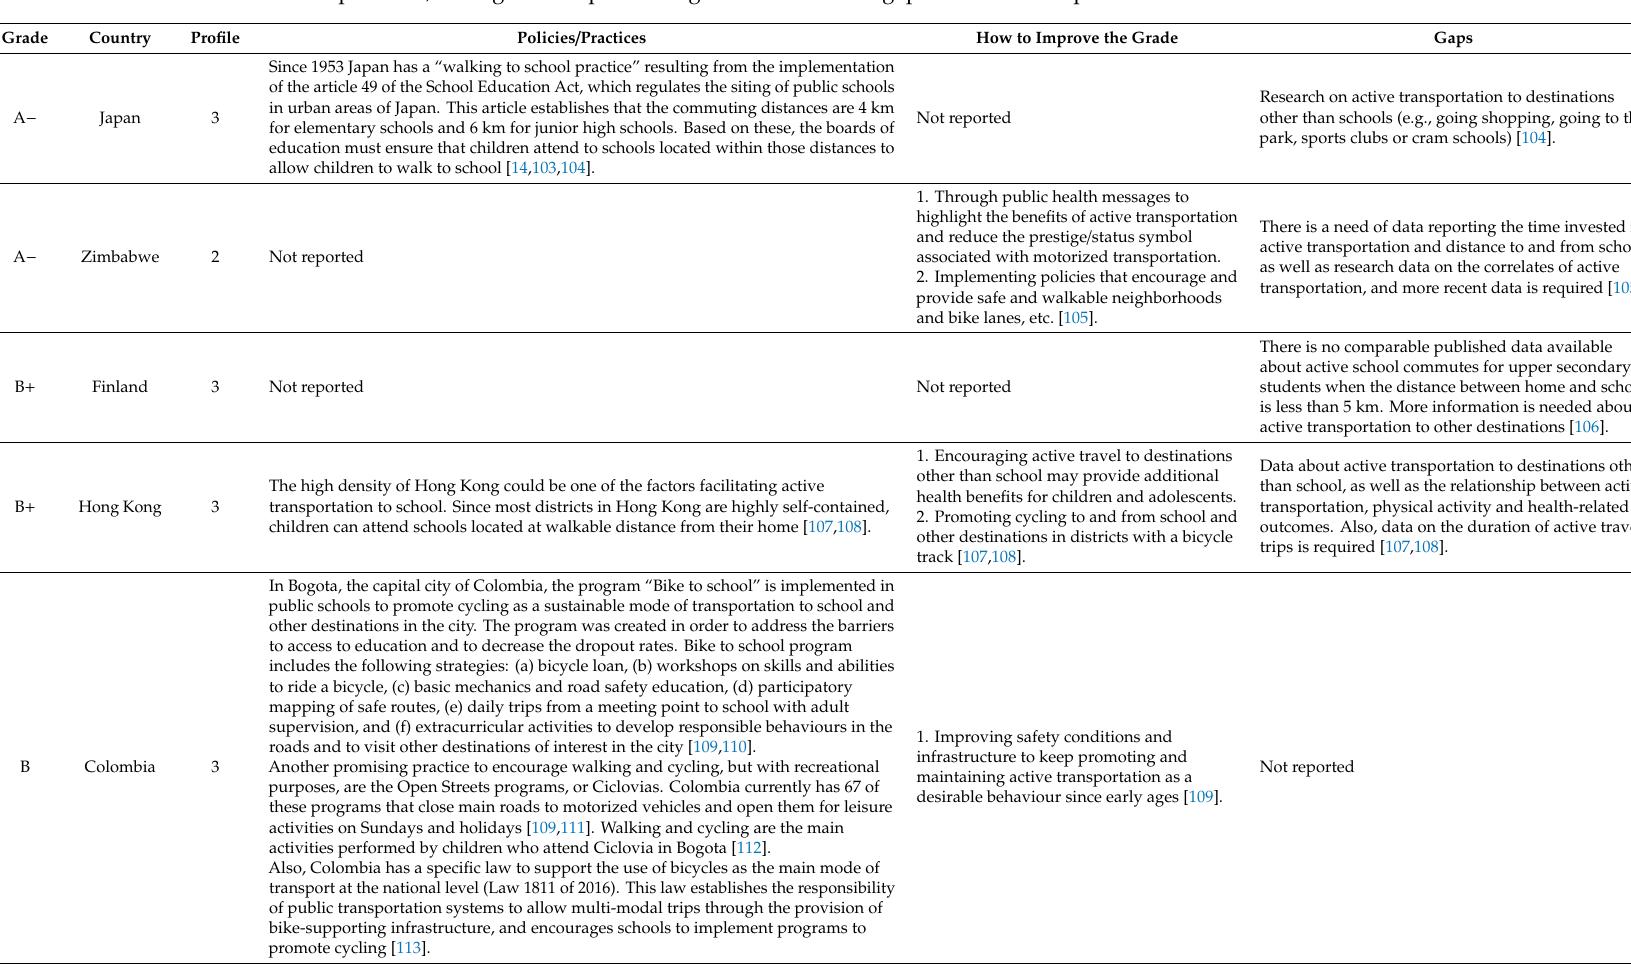
Table 5. Policies and practices, strategies to improve the grade and research gaps in active transportation identified in the Global Matrix